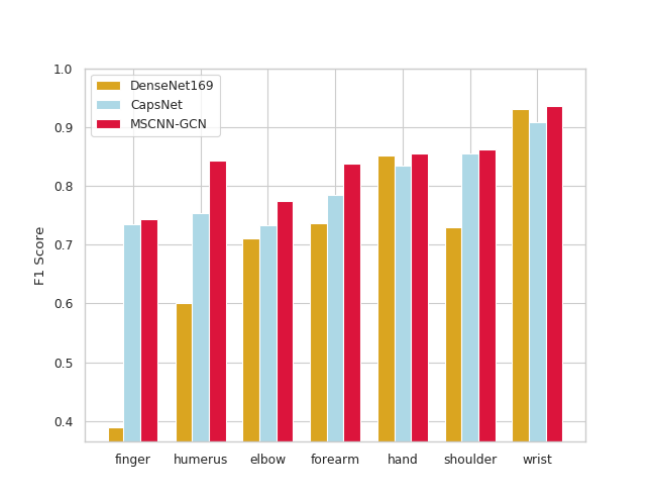
Figure 6. Kappa score of DenseNet169, CapsNet and MSCNN-GCN. Table 4. F1 score obtained by radiologists, DenseNet169, and MSCNN-GCN.